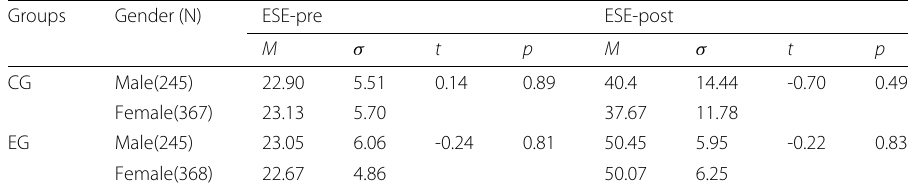
Table 5 t -test statistics of gender and experimental self-efficacy Groups Gender